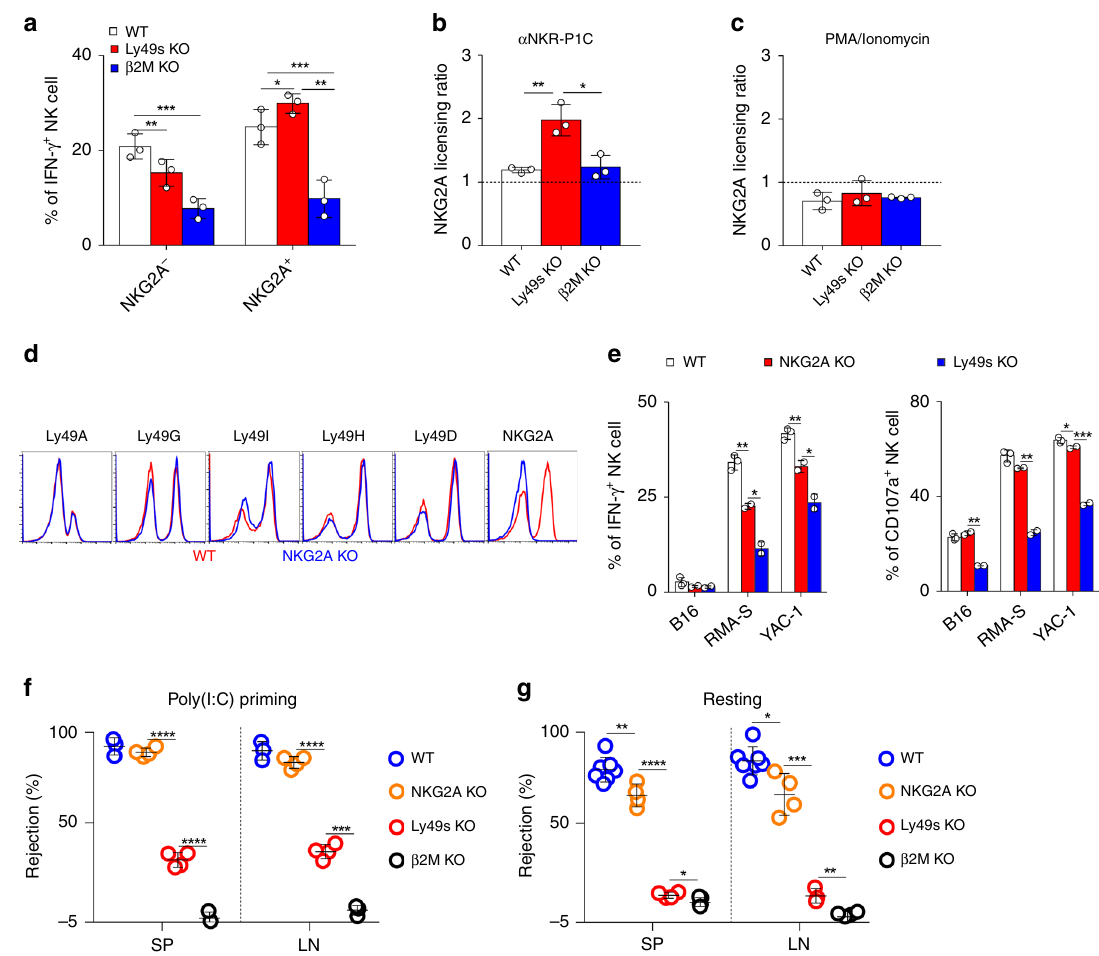
Fig. 6 NKG2A-de fi cient mice display minor defects in NK-cell activity. a Poly(I:C)-primed splenocytes from the indicated mice were stimulated with plate- coated anti-NKR-P1C. Percentages of IFN- γ + gated CD3 − NKp46 + NK cells were analysed. b , c Licensing ratio of NKG2A for stimulation with plate-coated anti-NKR-P1C ( b ) or PMA and ionomycin ( c ). Licensing ratio is relative production of IFN- γ by NKG2A + cells within gated CD3 − NKp46 + NK